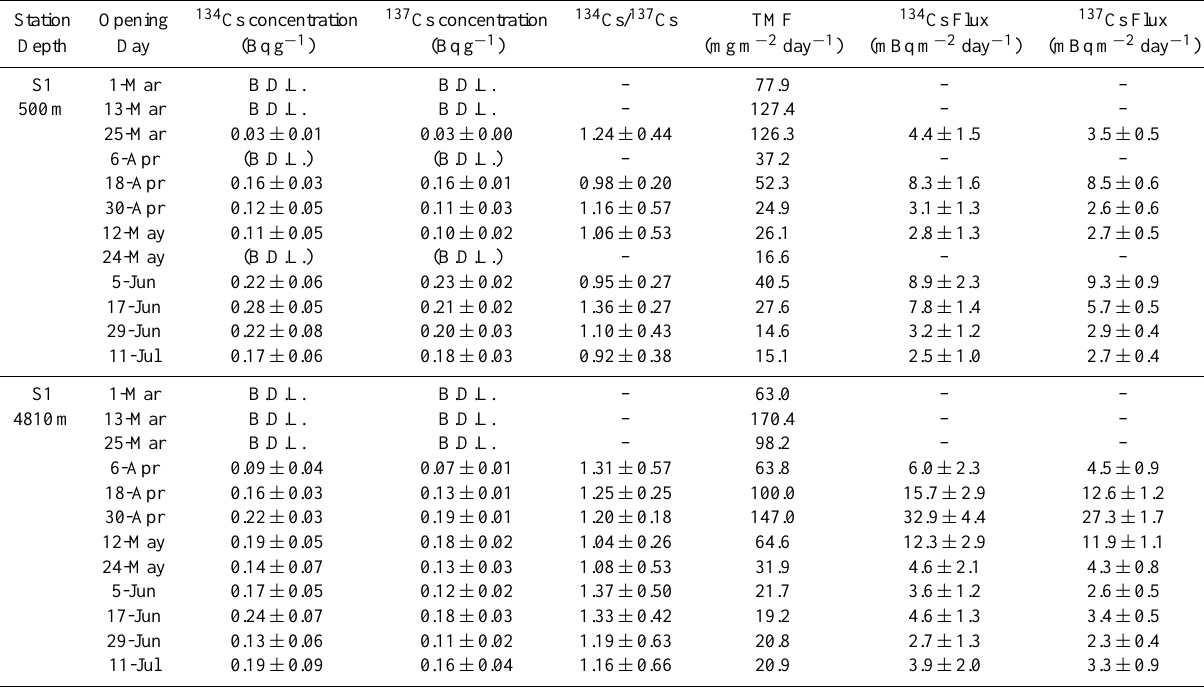
Table 2. Concentrations and fluxes of radiocesium at S1. The analytical error is based on one sigma of counting statistics. Activities are decay-corrected based on the middle day of each sampling period. B.D.L. is below detection limit (0.01Bq). (B.D.L.) is supposed to be below detection limit because of insufficient sample mass and activity by gamma